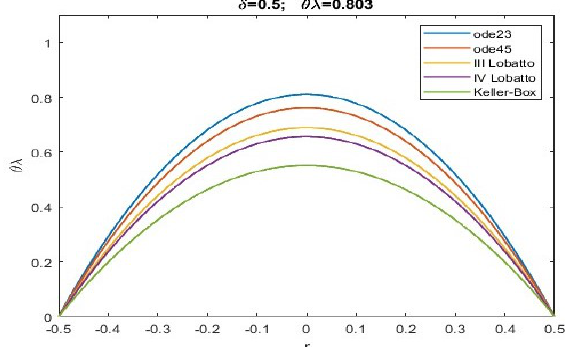
Figure 3. Recovering of u ( r ) for δ = 0 and θλ = 0.813.